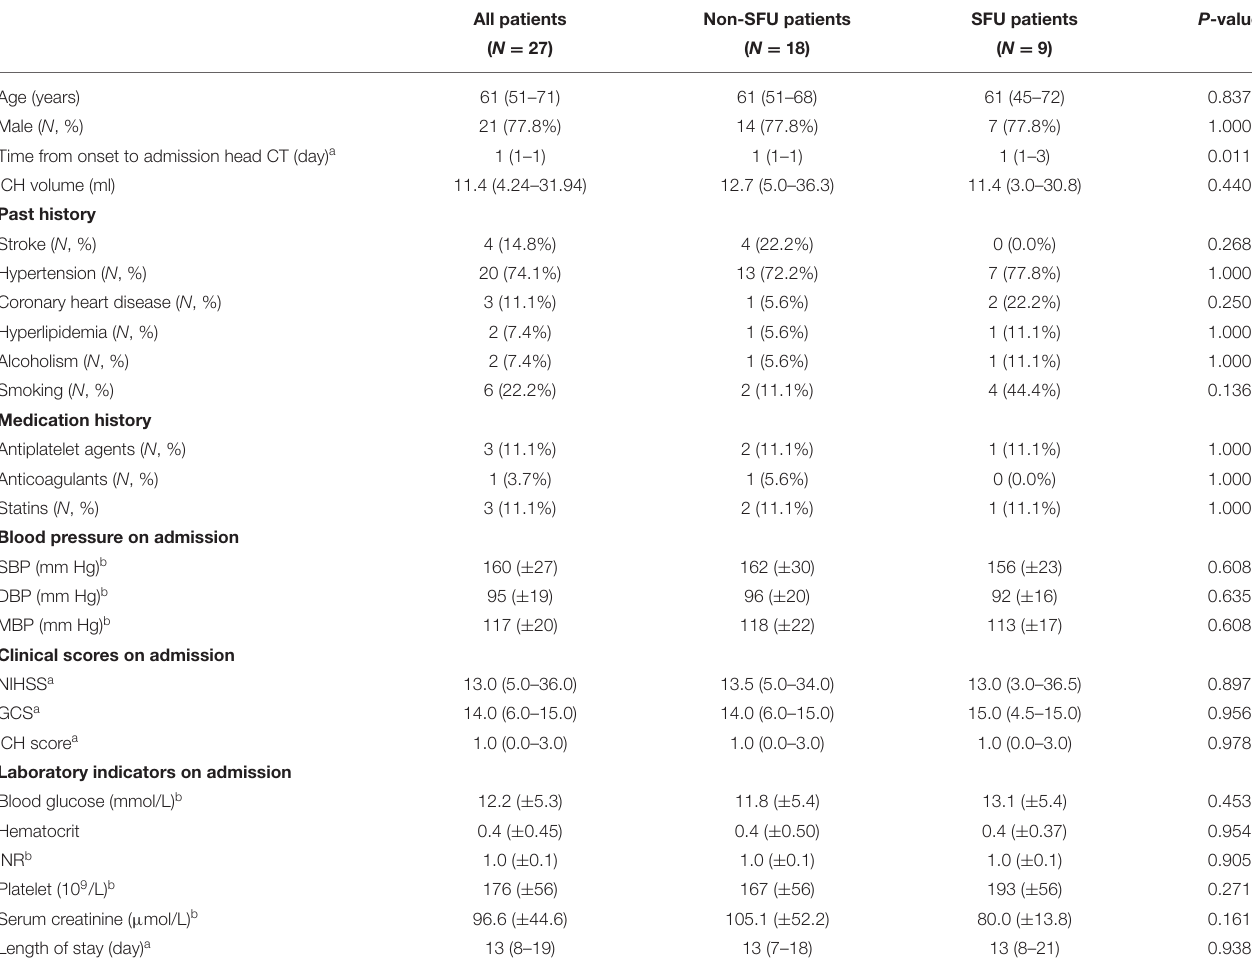
TABLE 1 | Baseline characteristics of sulfonylureas (SFU) and non-SFU patients.